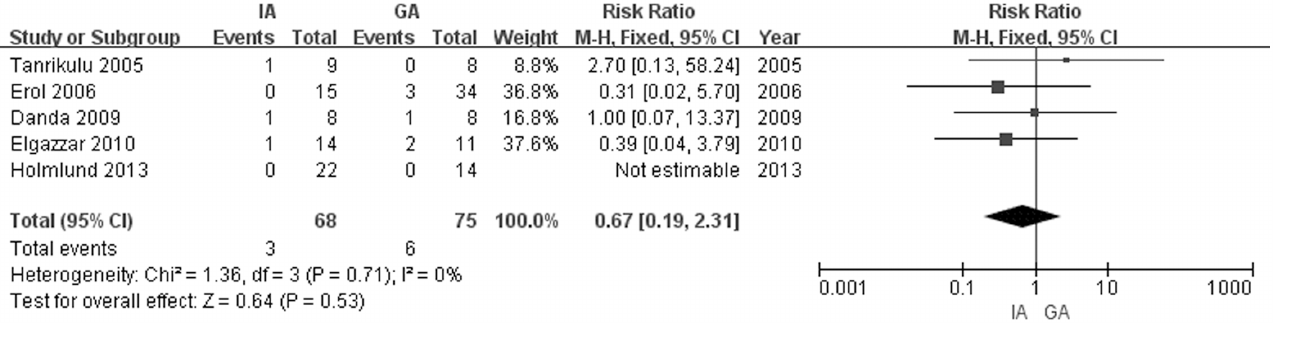
Fig 3. Forest plot of the occurrences of reankylosis — GA vs. IA (TMF).